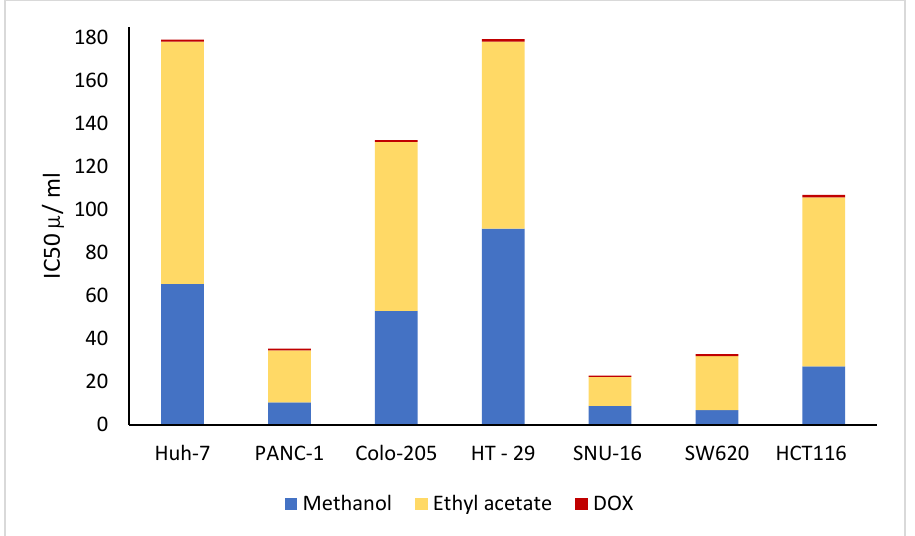
Figure 10. IC 50 of K. pinnata mature fruit methanolic and ethyl acetate extracts and the DOX drug on a dose – response graph.